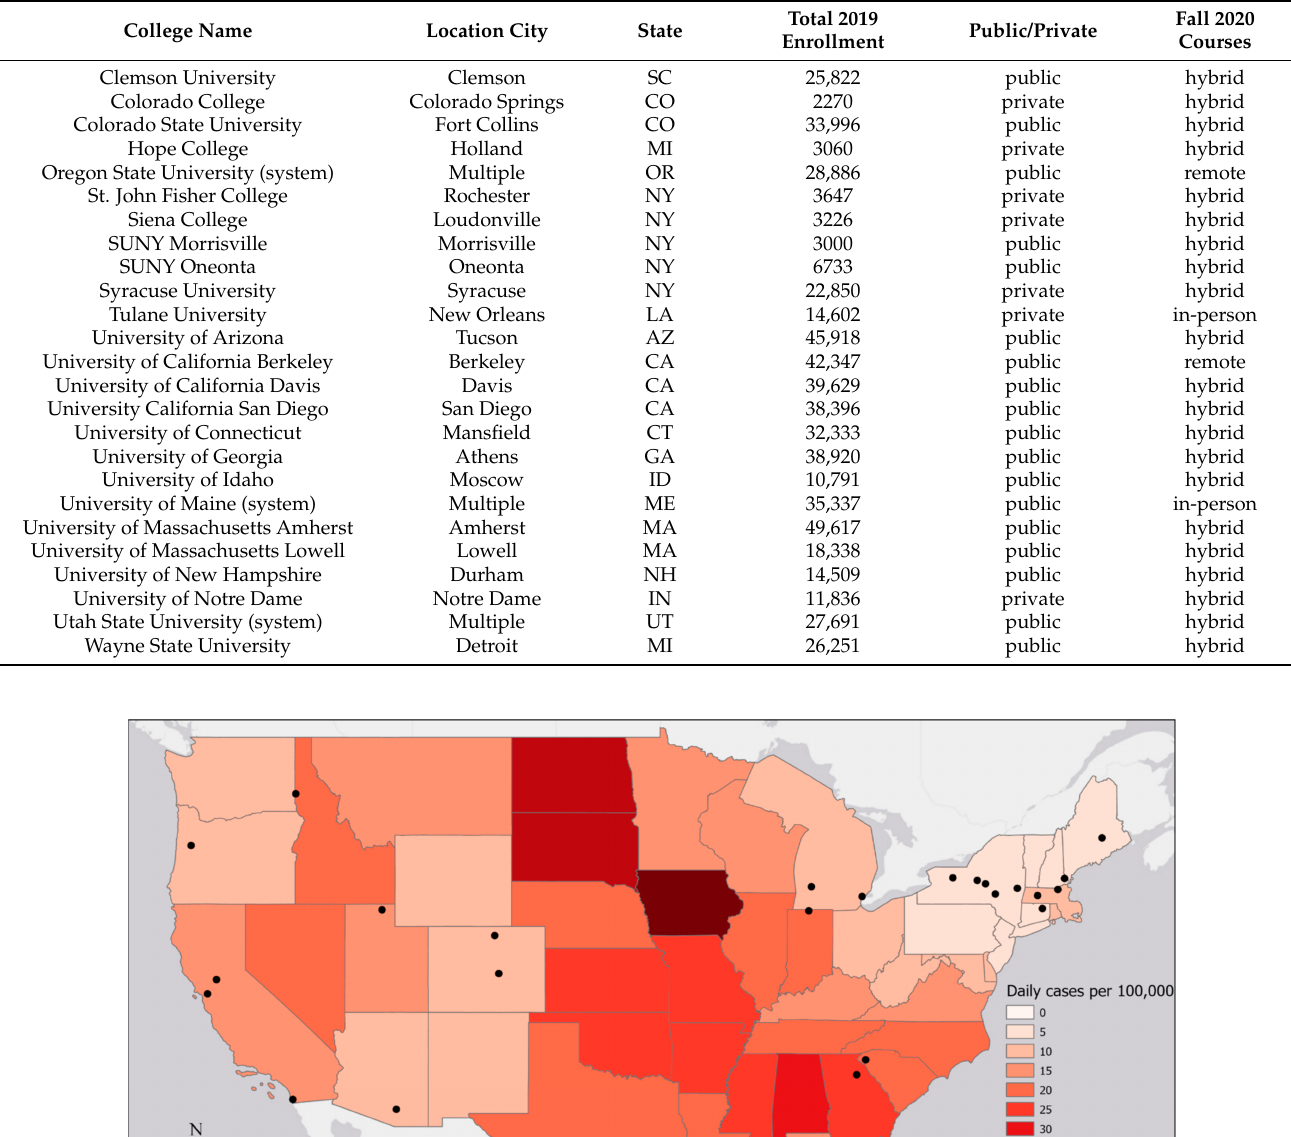
Table 1. Characteristics of case study colleges.